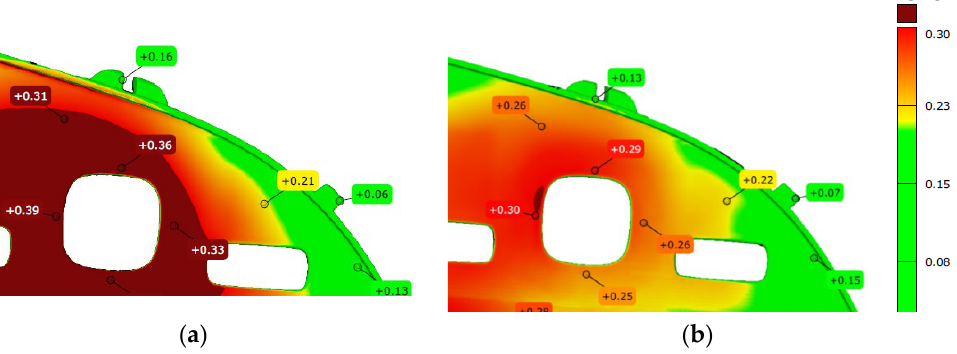
Figure 6. The results of optical measurements of: ( a ) a part out from the cavities 3, 4, 5, and 6; ( b ) a part out from the cavities the cavities 1, 2, 7, and 8.